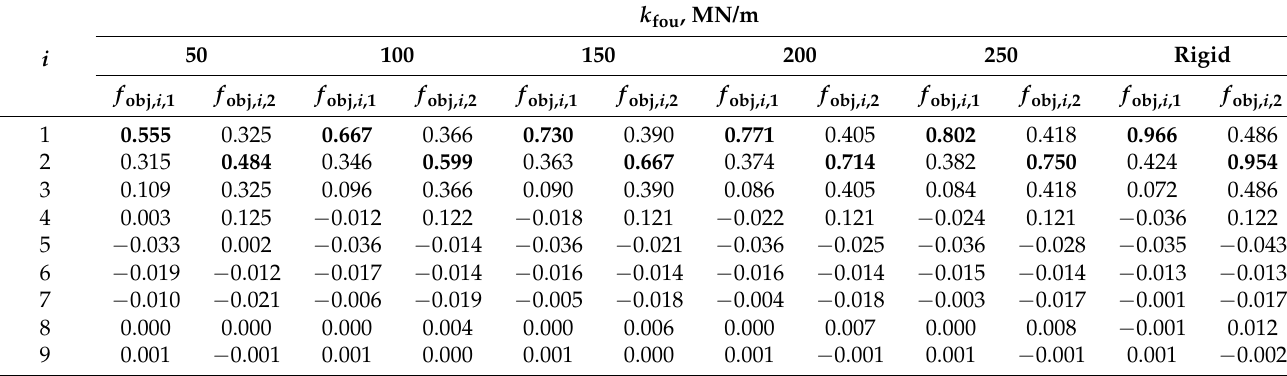
Table A9. Values f obj, i , j , [-] of the matrix f obj of object displacement forms for n = 16, k fou = 50, 100, 150, 200, 250 MN/m and k fou - rigid (elements f obj, i , i ( i = j ) are given in bold).